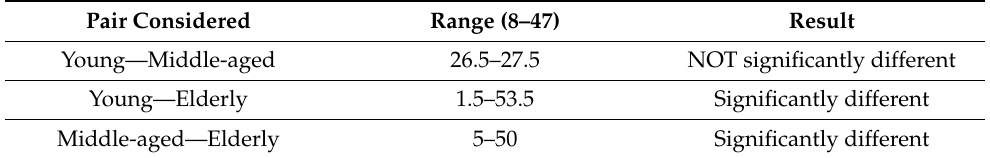
Table 4 details the numerical results of the simulation tests related to Group 1. Table 3. Results of the Wilcoxon signed-rank test.